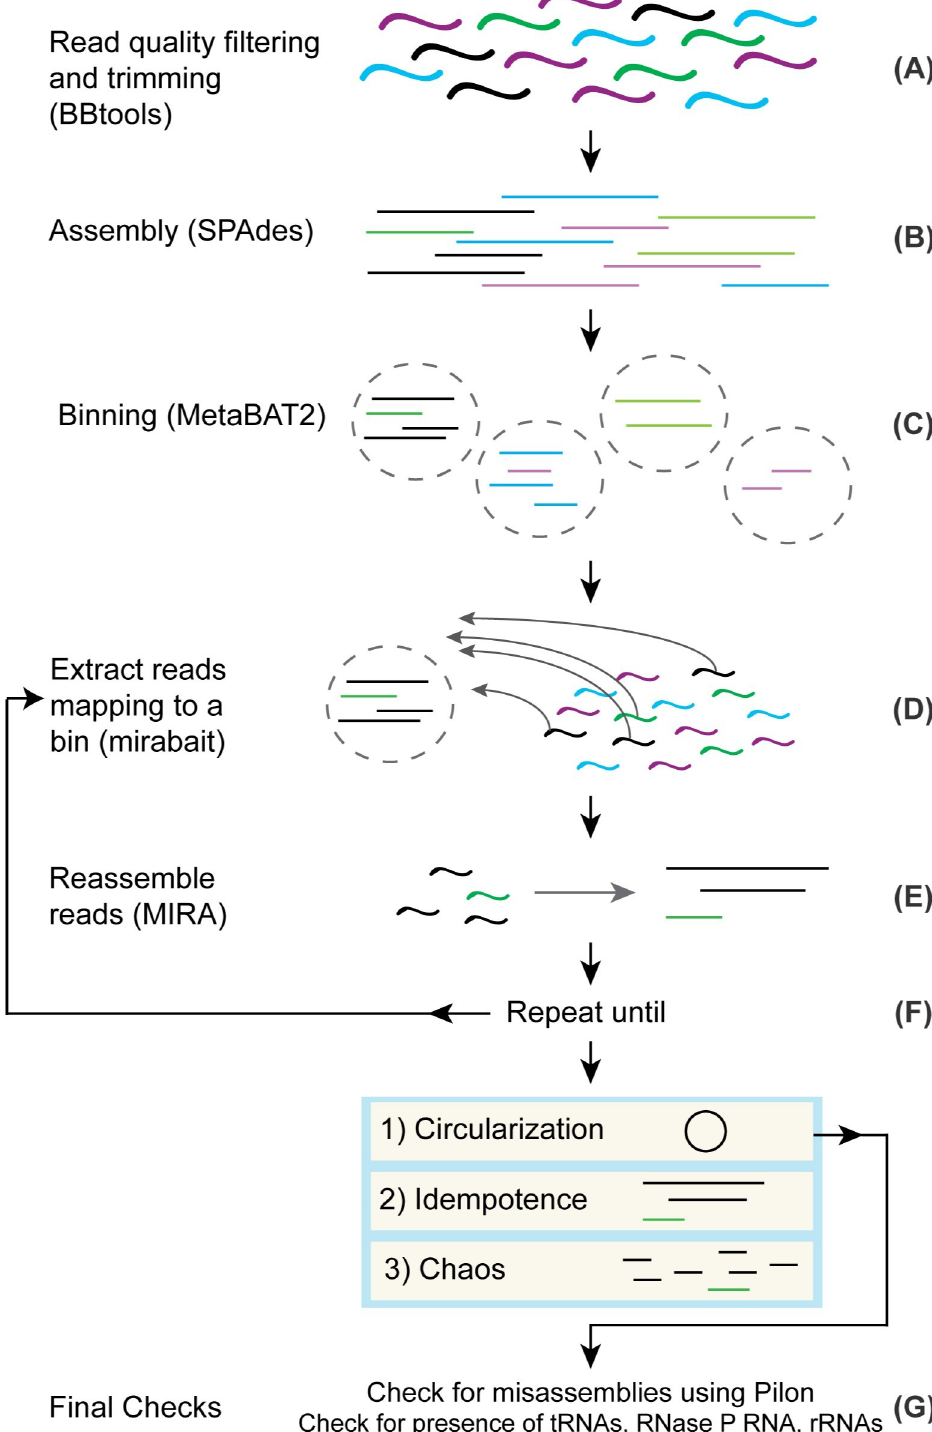
Fig 1. General method for circularizing genomes from metagenomes. (A) Reads have adapters trimmed and low- quality reads are filtered using BBtools. (B) Processed reads are assembled into contigs using SPAdes. (C) Contigs are grouped into bins using MetaBAT 2. (D) After choosing a bin for circularization, reads mapping to the bin are extracted from the original processed reads and used as input into (E) where they are assembled into contigs using MIRA. (F) Steps D and E are repeated as necessary until the bin is deemed to be in a Circularization, Idempotence,